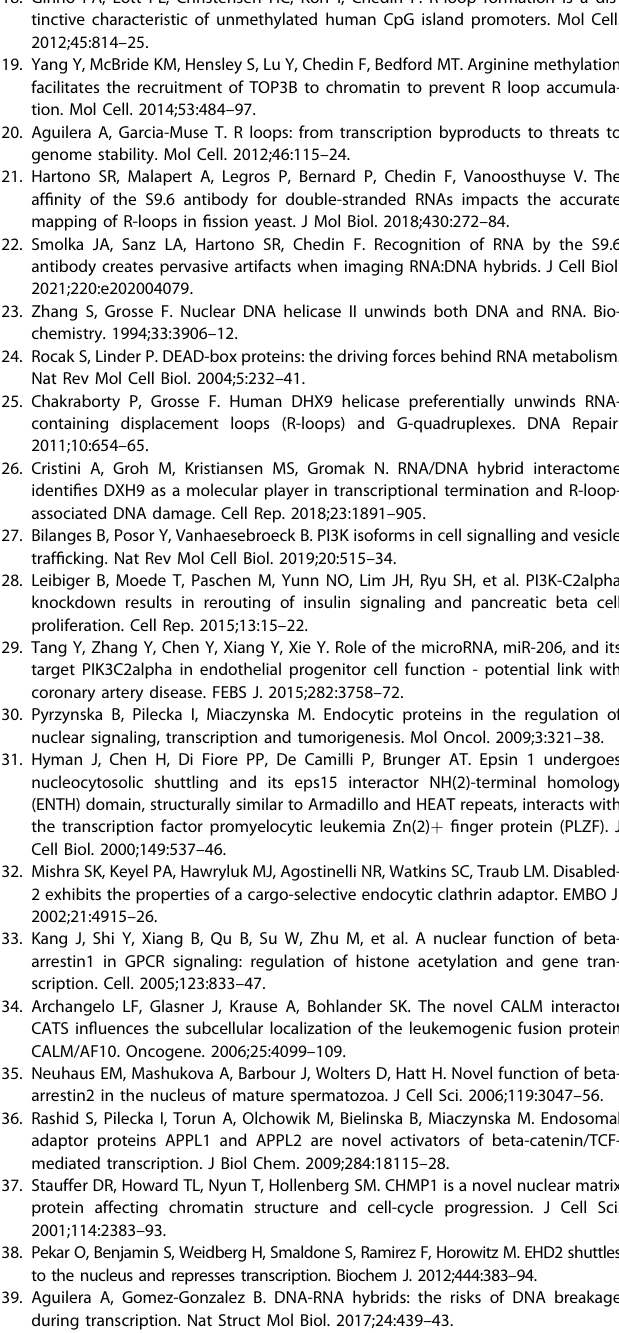
Fig. 8 Clinical data demonstrated that patients with a high cytoplasmic ITSN1-S and a positive nuclear ITSN1-S expression had the best prognosis outcome. A The mRNA expression levels of ITSN1 in multiple tumor tissues and paired normal tissues in the GEPIA database. The red dots and green dots represented tumor tissues and normal tissues, respectively. The mRNA expression levels of ITSN1 in breast cancer tissues ( n = 1085) and paired normal breast tissues ( n = 291) in GEPIA database ( * P < 0.05). B OS (left panel) and RFS (right panel) curves of breast cancer patients with ITSN1 mRNA expression in Kaplan – Meier plotter database (log-rank test). C OS (left panel) and PFS (progression- free survival, right panel) curves of IDC patients with ITSN1-S expression (log-rank test). D OS (left panel) and PFS (right panel) curves of IDC patients with ITSN1-S positive nuclear expression (Nuc-positive) or ITSN1-S negative nuclear expression (Nuc-negative) (log-rank test). E OS (left panel) and PFS (right panel) curves of IDC patients with ITSN1-S high cytoplasmic expression (Cyto-high) or ITSN1-S low cytoplasmic expression (Cyto-low) (log-rank test). F OS (left panel) and PFS (right panel) curves of IDC patients with both cytoplasmic and nuclear ITSN1-S expression (log-rank test). G IDC patients with Cyto-high/Nuc-positive ITSN1-S expression showed a longer OS than others (log-rank test). H A proposed schematic model of ITSN1-S function in breast cancer